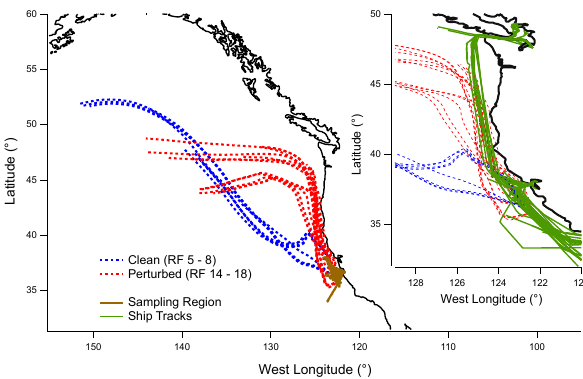
Fig. 9. Back-trajectories (72h) of cloud water samples collected during clean (blue) and perturbed (red) flights. Back-trajectories were calculated using the NOAA HYSPLIT model (available at: http://www.arl.noaa.gov/ready/hysplit4.html). Simulations were initialized with trajectories ending at the time, location and altitude of cloud water sampling. Inset shows a closer perspective of the Cal- ifornia coast. The green traces are the ship tracks of 15 cargo and tanker ships probed during the campaign and illustrate the general location of the shipping lanes north of Long Beach,